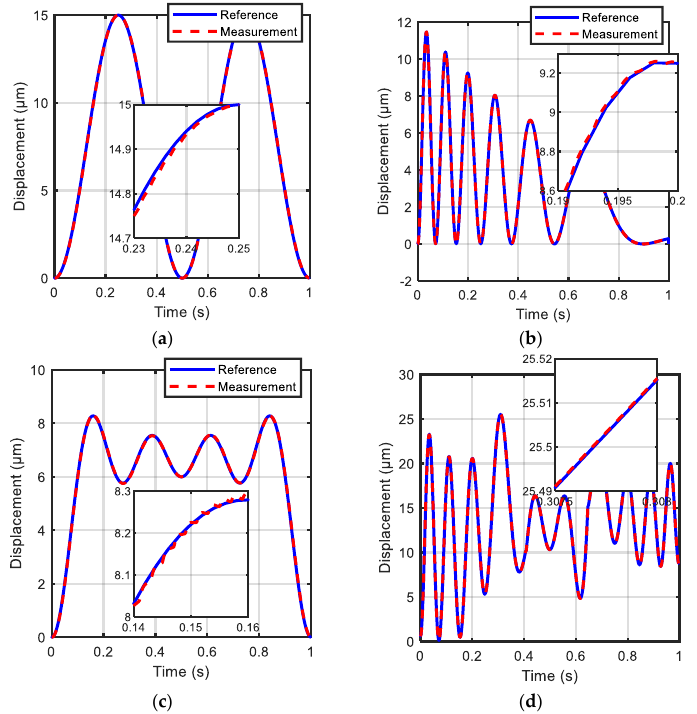
Figure 14. Experimental results of reference tracking in a closed loop with RST control and LSSVM compensation. These results were obtained by: ( a ) test reference D; ( b ) test reference E; ( c ) test reference F; and ( d ) test reference G.